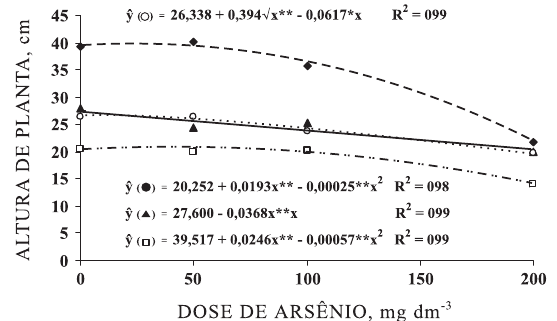
Figura 3. Altura de plantas de aveia ( ), azevém ( ), amendoim ( ) e estilosante ( ) em diferentes doses de As cultivadas em amostras de um LVA de João Pinheiro-MG. ** e *: significativo a 1 e 5 % respectivamente, pelo teste